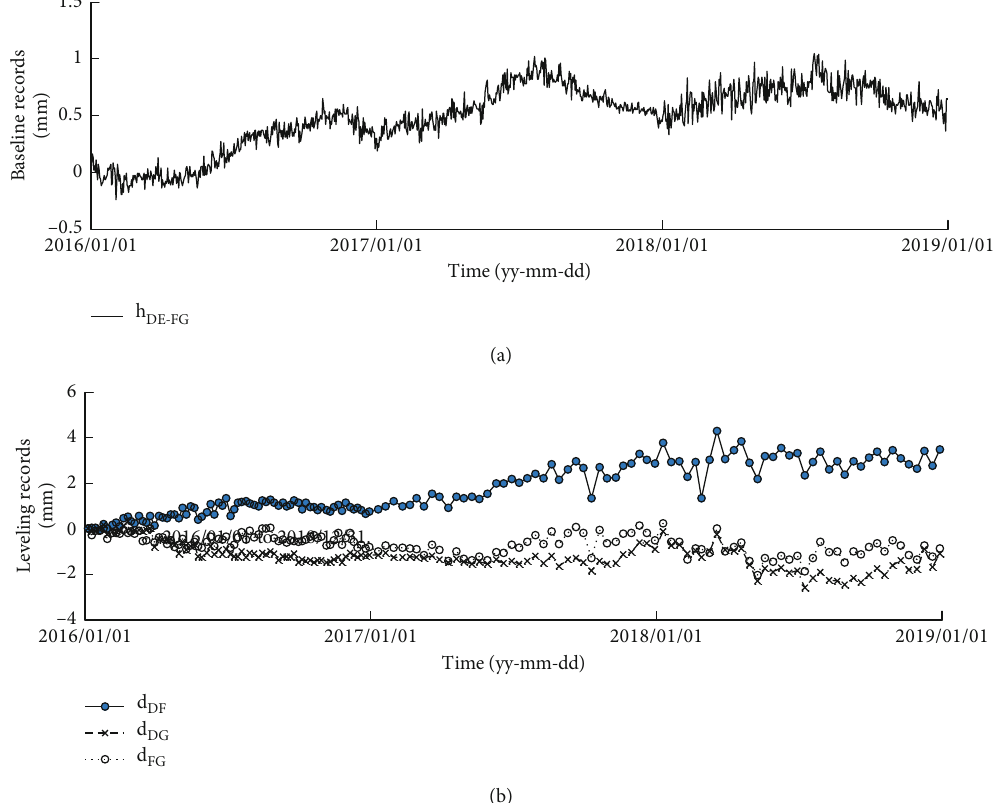
Figure 2: (a) Leveling records and (b) baseline records of the crossfault measurements from 2016/01/01 to